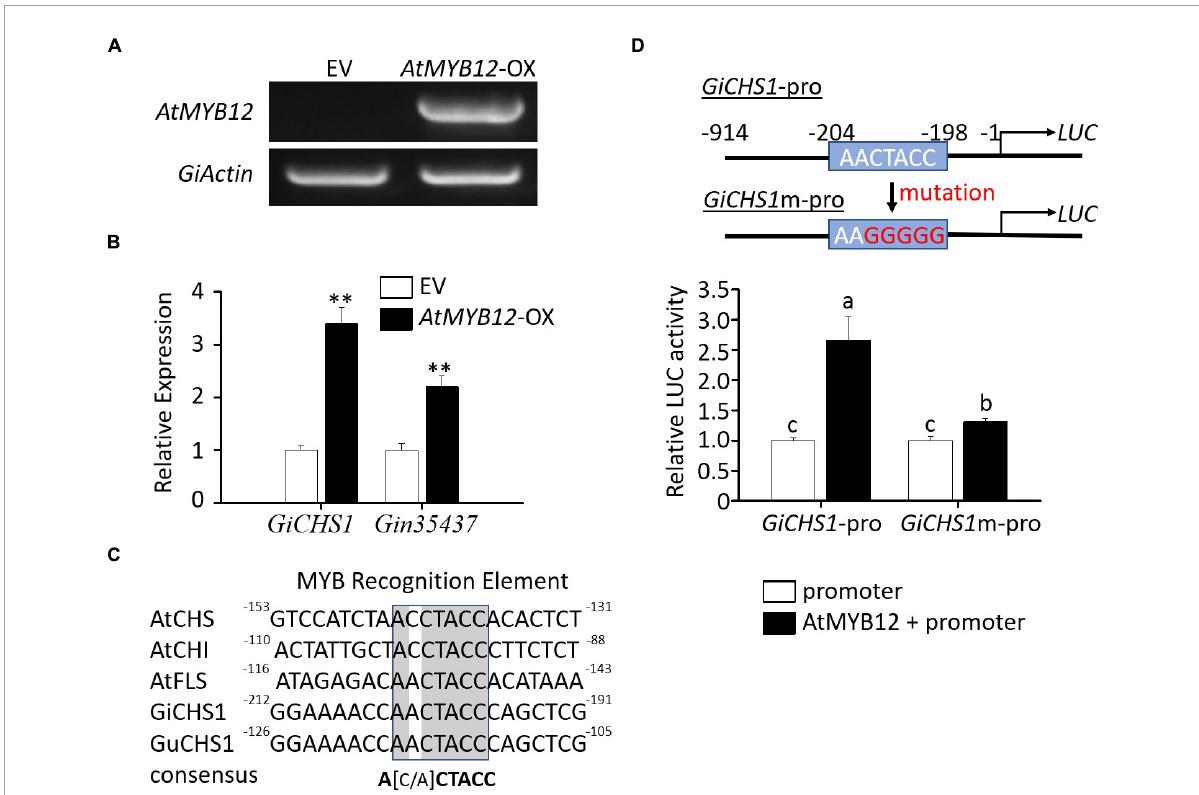
FIGURE3 Molecular analysis of G. inflata seedlings transiently overexpressing AtMYB12 and transactivation assay of the GiCHS1 promoter. (A) RT-PCR analysis showed AtMYB12 expression in G. inflata AtMYB12 -OX seedlings but not in EV seedlings. The G. inflata actin gene ( GiActin ) served as internal control. (B) Relative expression of the two GiCHS genes in AtMYB12 -OX seedlings was measured using qRT-PCR. GiActin was used as an internal control for normalization. Data are presented as the mean of three biological replicates ± SD. Asterisks indicate statistically significant differences compared with EV lines ( ∗∗ p < 0.01, Student’s t -test). (C) Similar to the promoters of Arabidopsis CHS , CHI, and FLS , GiCHS1 and GuCHS1 promoters also contain the MYB recognition elements (MRE). Numbers by the ends of the DNA sequences, such as -130 at the right end of AtCHS promoter sequence, represent positions relative to translation start site. (D) The diagram in the right shows the MRE in the GiCHS1 promoter ( GiCHS1 -pro) and the mutated MRE sequence in the mutant promoter ( GiCHS1m -pro). LUC , the reporter luciferase gene. Left panel shows transactivation of GiCHS1 -pro and GiCHS1m -pro after infiltration of the promoter vector alone or in combination with the AtMYB12-expression vector into tobacco cells. Data presented as the mean of biological replicates ± SD ( n = 3). Asterisks indicate statistically significant differences compared with EV lines ( ∗∗ p < 0.01, Student’s t